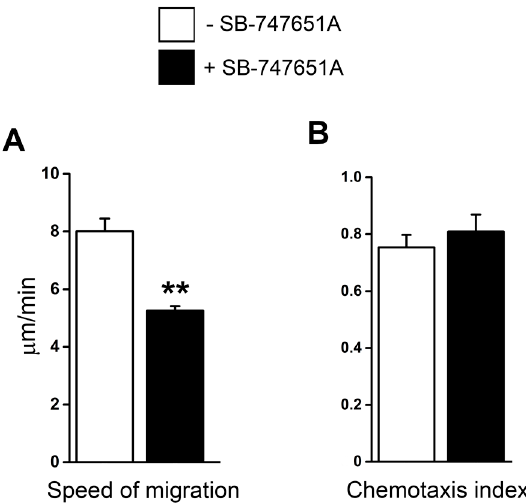
Figure 4. Effect of SB-747651A on CXCL2-induced neutrophil migration and chemotaxis in tissue. ( A ) The neutrophil migration speed (µm/min) and ( B ) the chemotaxis index of migrating neutrophils in response to CXCL2 stimulation in the absence (Control, white bar) or in the presence (black bar) of MSK1 inhibitor SB-747651A (5 µM) 30 min prior to and 60 min following the placement of CXCL2-containing gel. Data are means ± SEM ( n = 4). ** indicates significant difference ( p < 0.01) from the Control.